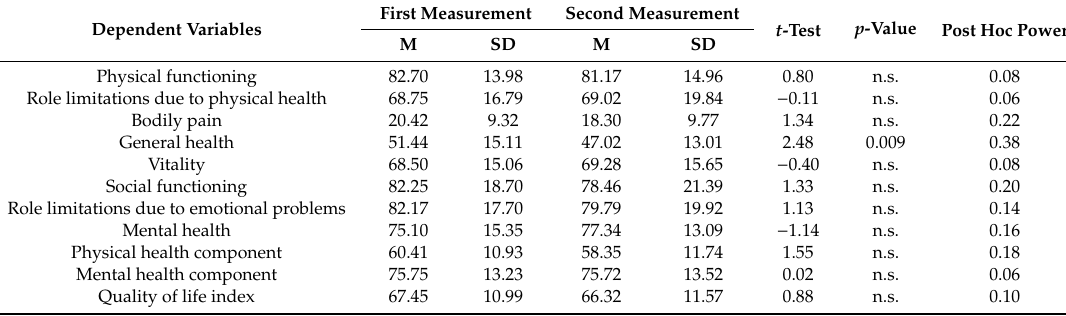
Table 3. The results of physical and mental aspects of health (Short Form Health Survey (SF-36)) before and after 12 weeks of the Nordic Walking training program and vitamin D supplementation. Dependent